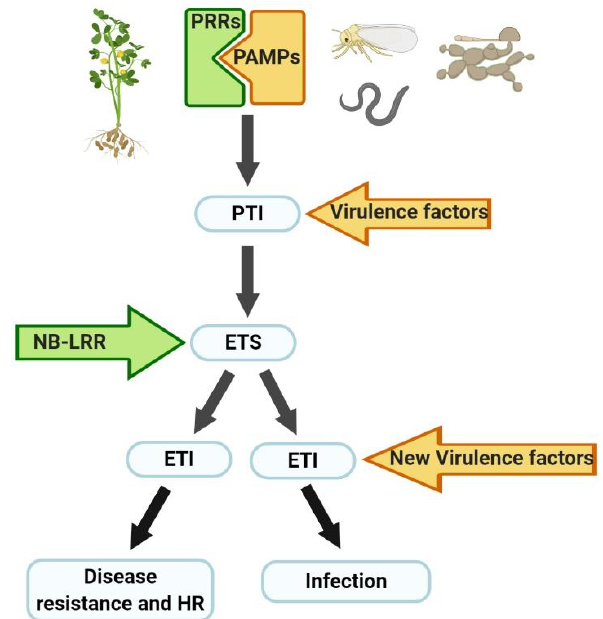
Figure 1. Plant defense mechanisms against the attack of pathogens. Pathogen recognition receptor (PRRs); pathogen-associated molecular patterns (PAMPs); PAMP-triggered immunity (PTI); effector-triggered susceptibility (ETS); nucleotide-binding and leucine-rich repeat domains (NB-LRR); effector-triggered immunity (ETI); hypersensitive cell death (HR).